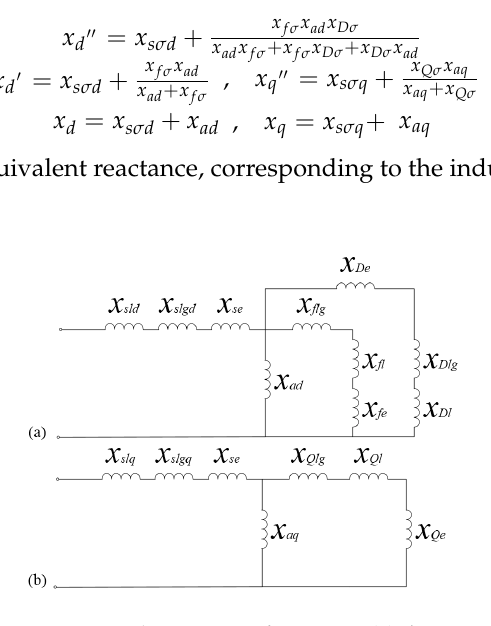
Table 1. Prototype data.